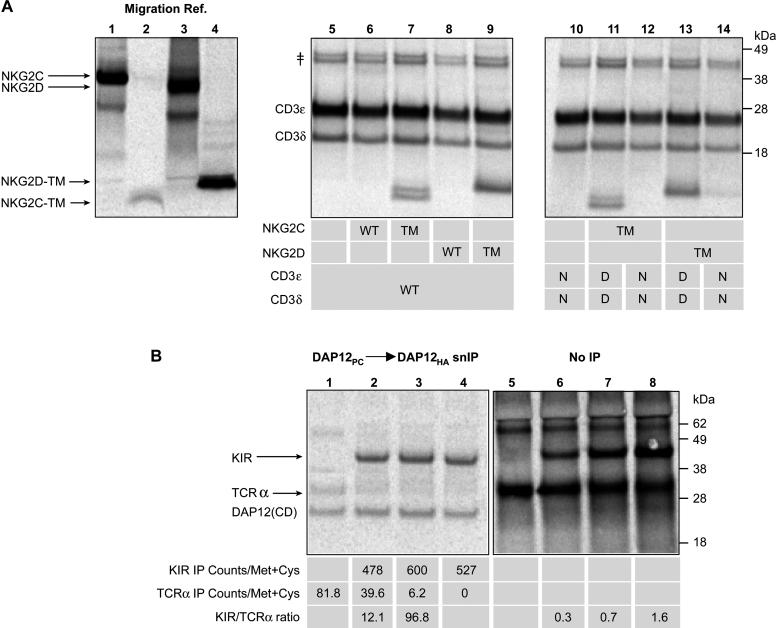
Mechanisms of Specificity II: Steric Hindrance and Competition for Assembly Partners(A) Steric hindrance between incompatible extracellular domains. Assembly of full-length NKG2C and NKG2D (WT) and the TM peptides of these two receptors (TM) with CD3δ was examined using an anti-CD3 mAb (UCH-T1) for IP analysis. The TM peptides, but not the full-length proteins, assembled with CD3δ (lanes 5–9). The interaction required the TM aspartic acid pair of CD3δ based on the analysis of mutants in which the aspartic acids (D) were substituted with asparagine (N) (lanes 10–14). The migration of the individual proteins is demonstrated in lanes 1–4 as a reference. A nonspecific dimer of CD3 is marked with a cross.(B) The KIR receptor out-competes an irrelevant receptor for DAP12-binding. All in vitro translation experiments were set up with 100 ng of DAP12 RNA and 150 ng of TCRα RNA, while 0, 50, 100, or 150 ng of KIR RNA was added to reactions 1–4. In the reaction without KIR (lane 1), a small amount of TCRα associated with the DAP12 dimer. In the presence of increasing concentrations of KIR (lanes 2–4), TCRα binding to DAP12 was lost. Complex formation was analyzed by two-step snIP targeting the PC and HA tags attached to DAP12. KIR and TCRα were quantitated following IP (lanes 1–4) as well as from aliquots of reactions not subjected to IP (lanes 5–8). IP counts were divided by the number of methionine and cysteine residues to reflect the molar ratio of KIR and TCRα chains, which is shown both before and following IP. SDS-PAGE was performed under nonreducing conditions. The images shown are representative of three experiments.